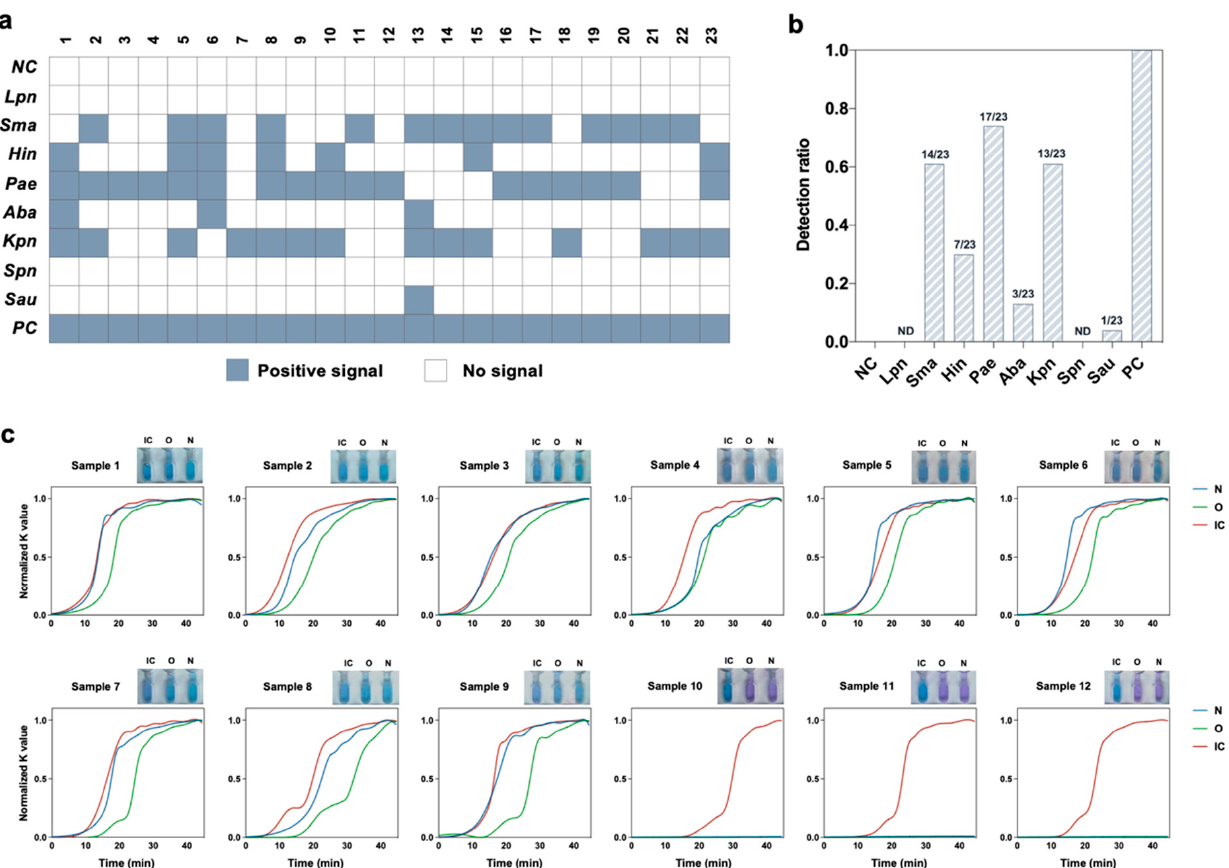
Figure 6. Clinical validation of our SMART system. ( a ) Detection of RNA extracted from human sputum specimens from 23 patients infected with respiratory pathogens. The gray-blue squares represent positive signals. The white squares represent no signal was detected. ( b ) Detection probability statistics of each respiratory pathogen. ( c ) Detection of COVID-19 clinical